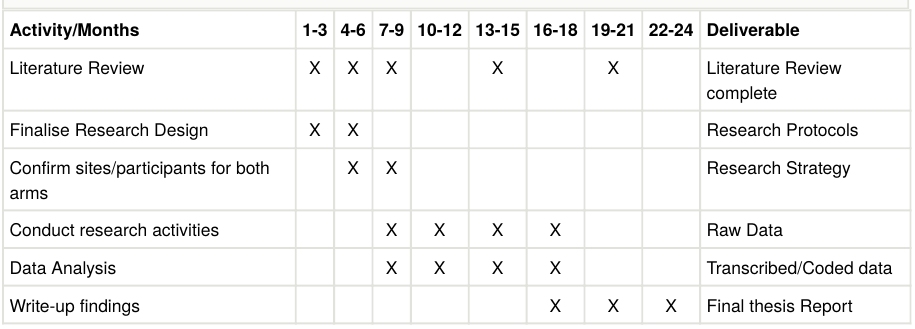
Time-frame for the